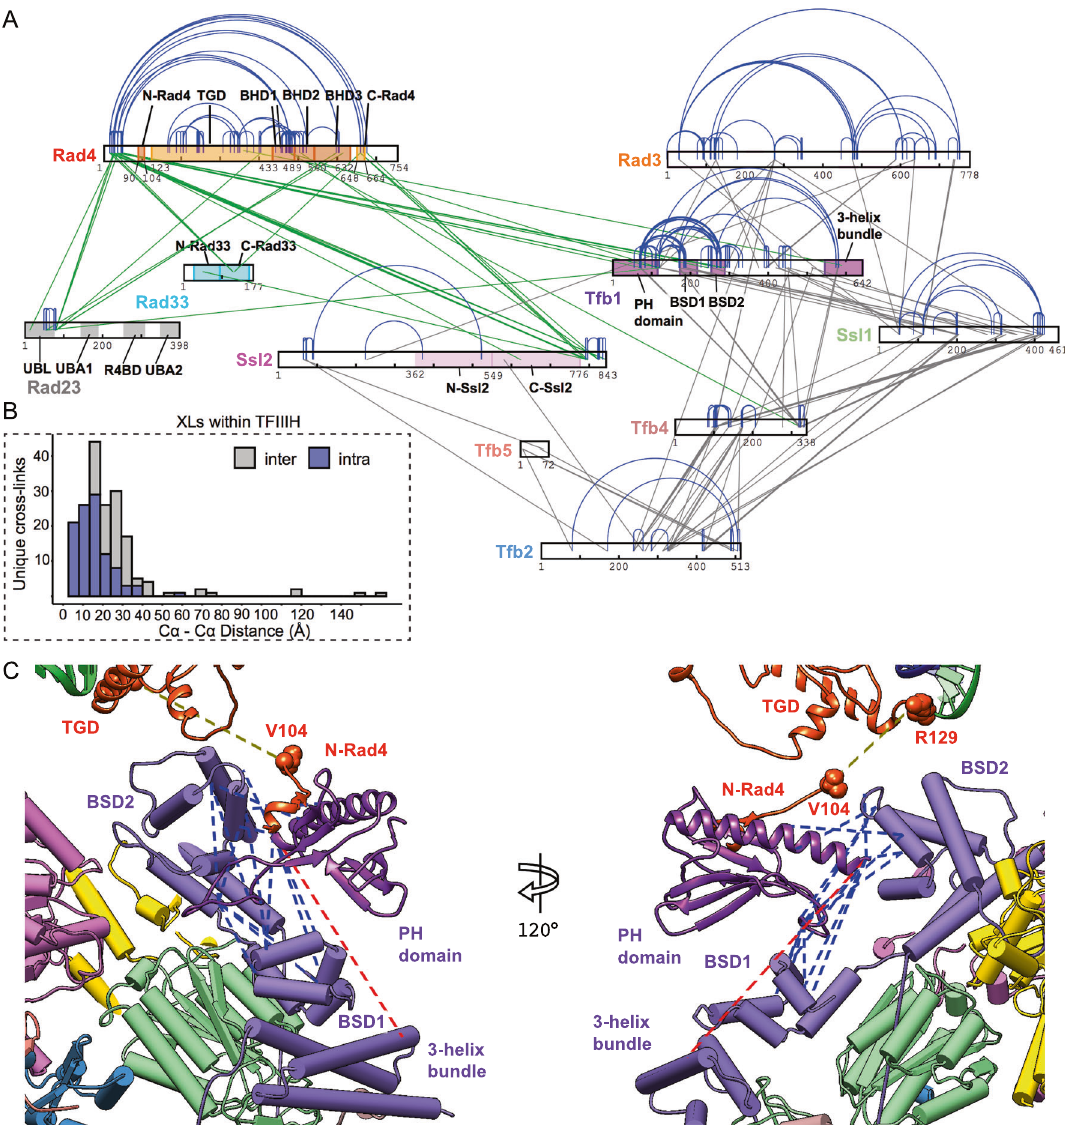
Fig. 2 Cross-linking and mass spectrometry of TFIIH/Rad4 – Rad23 – Rad33/DNA. A Non-redundant cross-links identi fi ed for TFIIH/Rad4 – Rad23 – Rad33 on − 24/ + 24 AAF-DNA as a network plot. Intra-subunit cross-links are shown in blue while inter-protein cross-links are shown in gray between TFIIH subunits and in green within Rad4 – Rad23 – Rad33 and between Rad4 – Rad23 – Rad33 and TFIIH. B Cross-links were validated by mapping them on the atomic model of TFIIH in this study. 93% of cross-links were consistent with the 40 Å upper limit. C Current model of the Tfb1 PH domain in TFIIH/ Rad4 – Rad23 – Rad33/DNA complex. Of 16 unique cross-links between the PH domain and the other domains of Tfb1, 15 cross-links had C α -C α distances less than 40 Å (blue dotted lines), and 1 cross-link exceed 40 Å (red dotted line).The N-terminal end of the TGD (R129) and the C-terminal end of N-Rad4 (V104) are connected by a green dashed